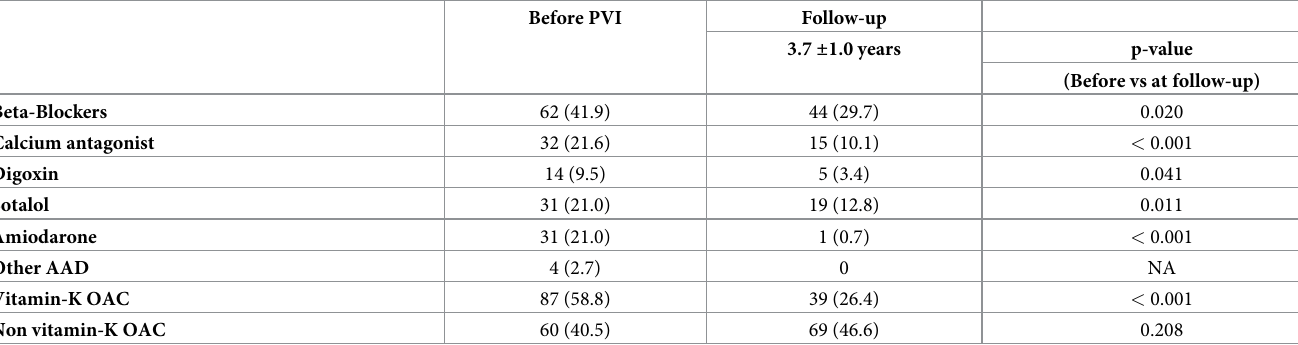
follow-up period. Kruskal-Wallis and Dunn’s test were used for multiple comparisons. Multi- ple test adjustment Bonferroni method was used for p-value adjustment. The Kaplan-Meier curve was used to analyse the time to first event outcomes: ATa, AF and AT recurrence. All rel- evant clinical variables are assessed in an univariate Cox proportional hazards analysis to iden- tify variables associated with ATa recurrence. Multivariate Cox proportional hazards analysis was performed with associated variables with a p-value < 0.100. Hazard Ratios (HR) are pre- sented with corresponding 95% confidence interval